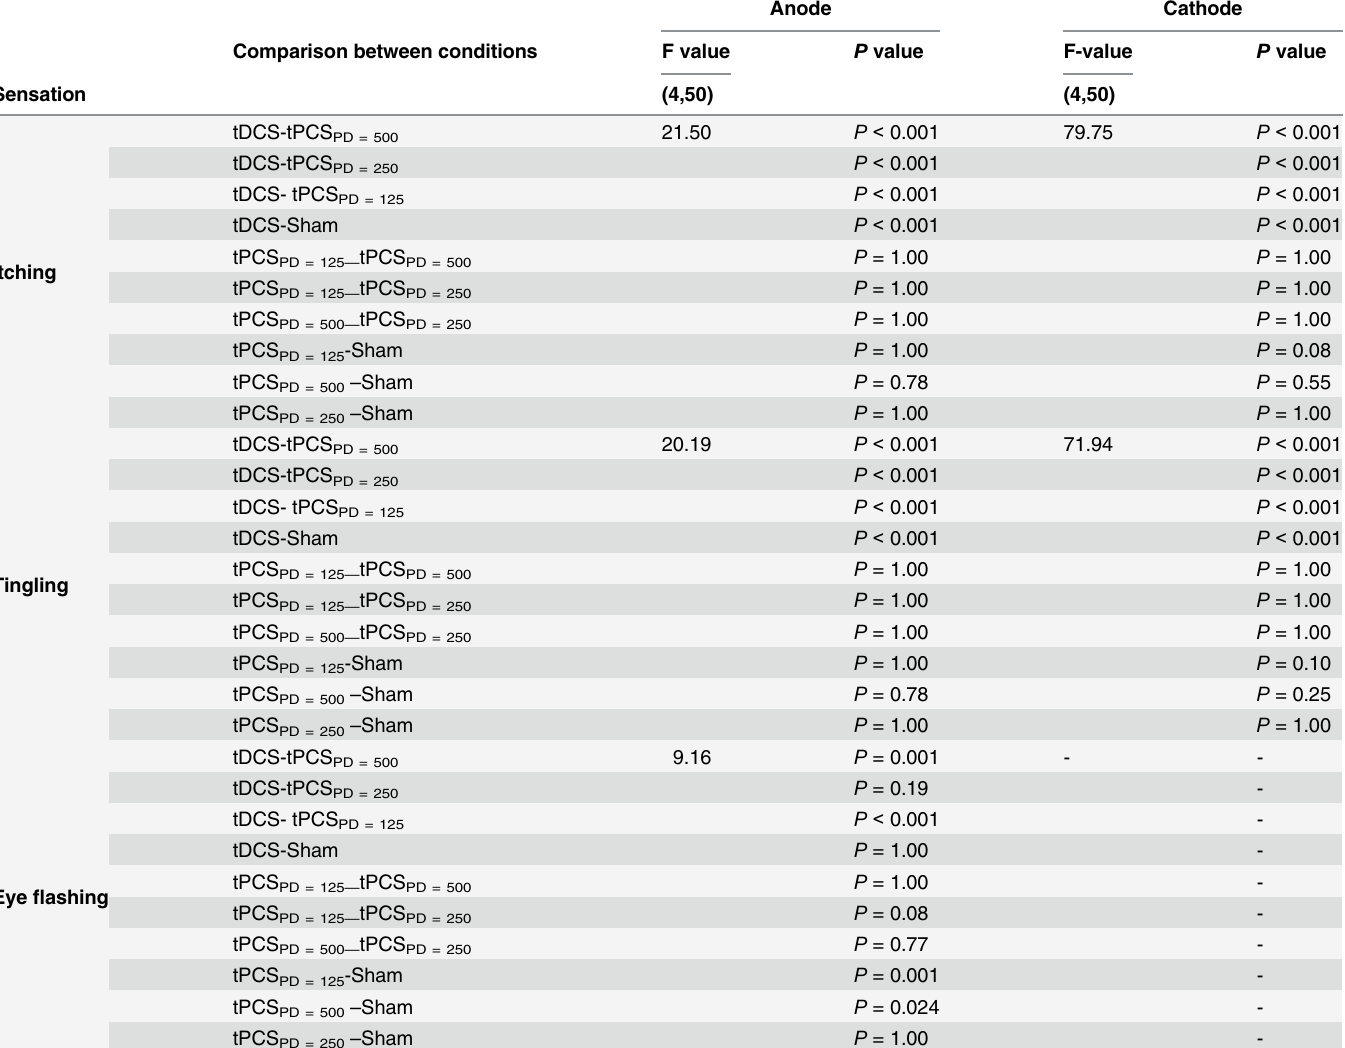
Table 2. Comparison of side effects between a-tDCS, a-tPCS PD = 125 , a-tPCS PD = 250 , a-tPCS PD = 500 and sham conditions. The results were consid- ered significant at the level of P < 0.05.